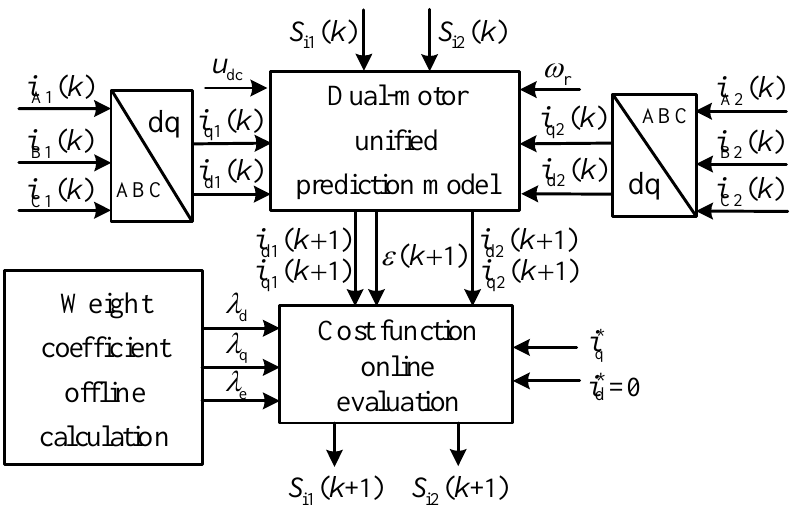
Figure 5. Inverter controller based on a finite set model predictive control (FCS-MPC) structure.